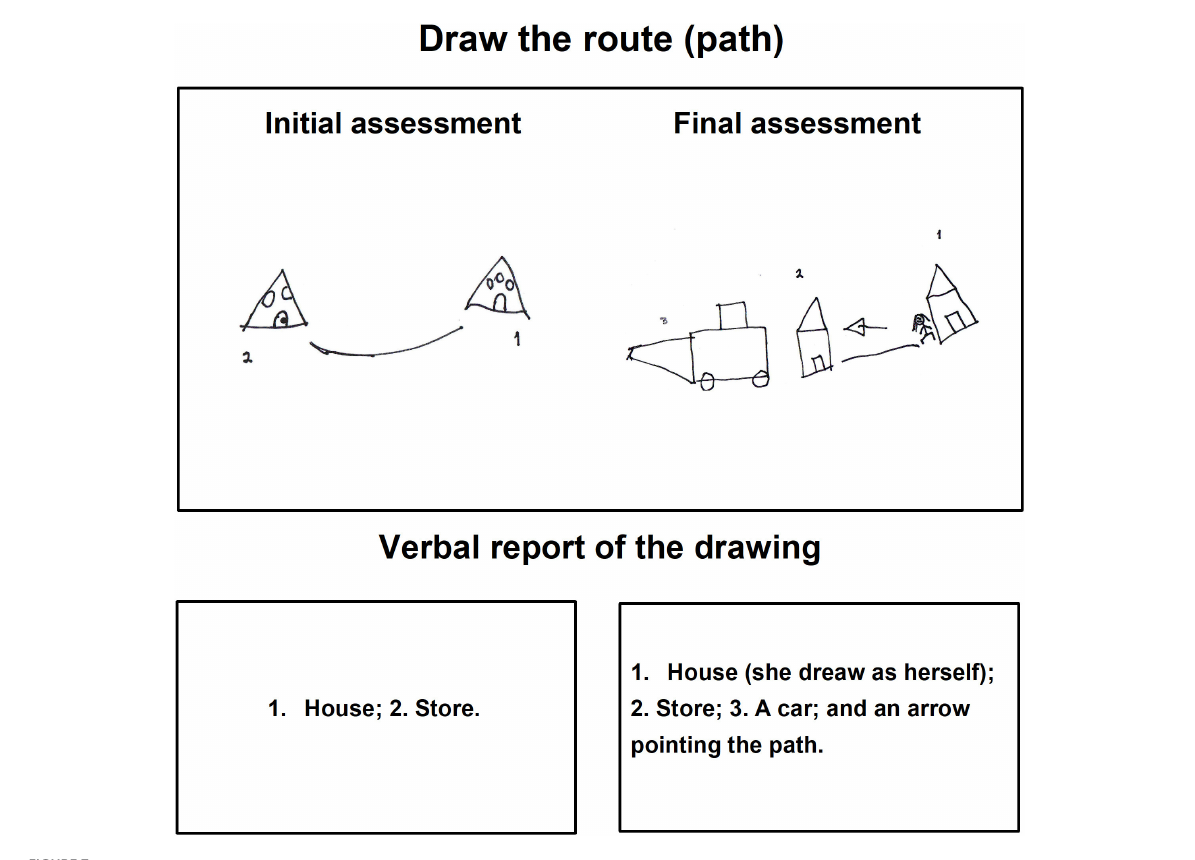
FIGURE7 Child G task drawing the route (path) during the initial and final